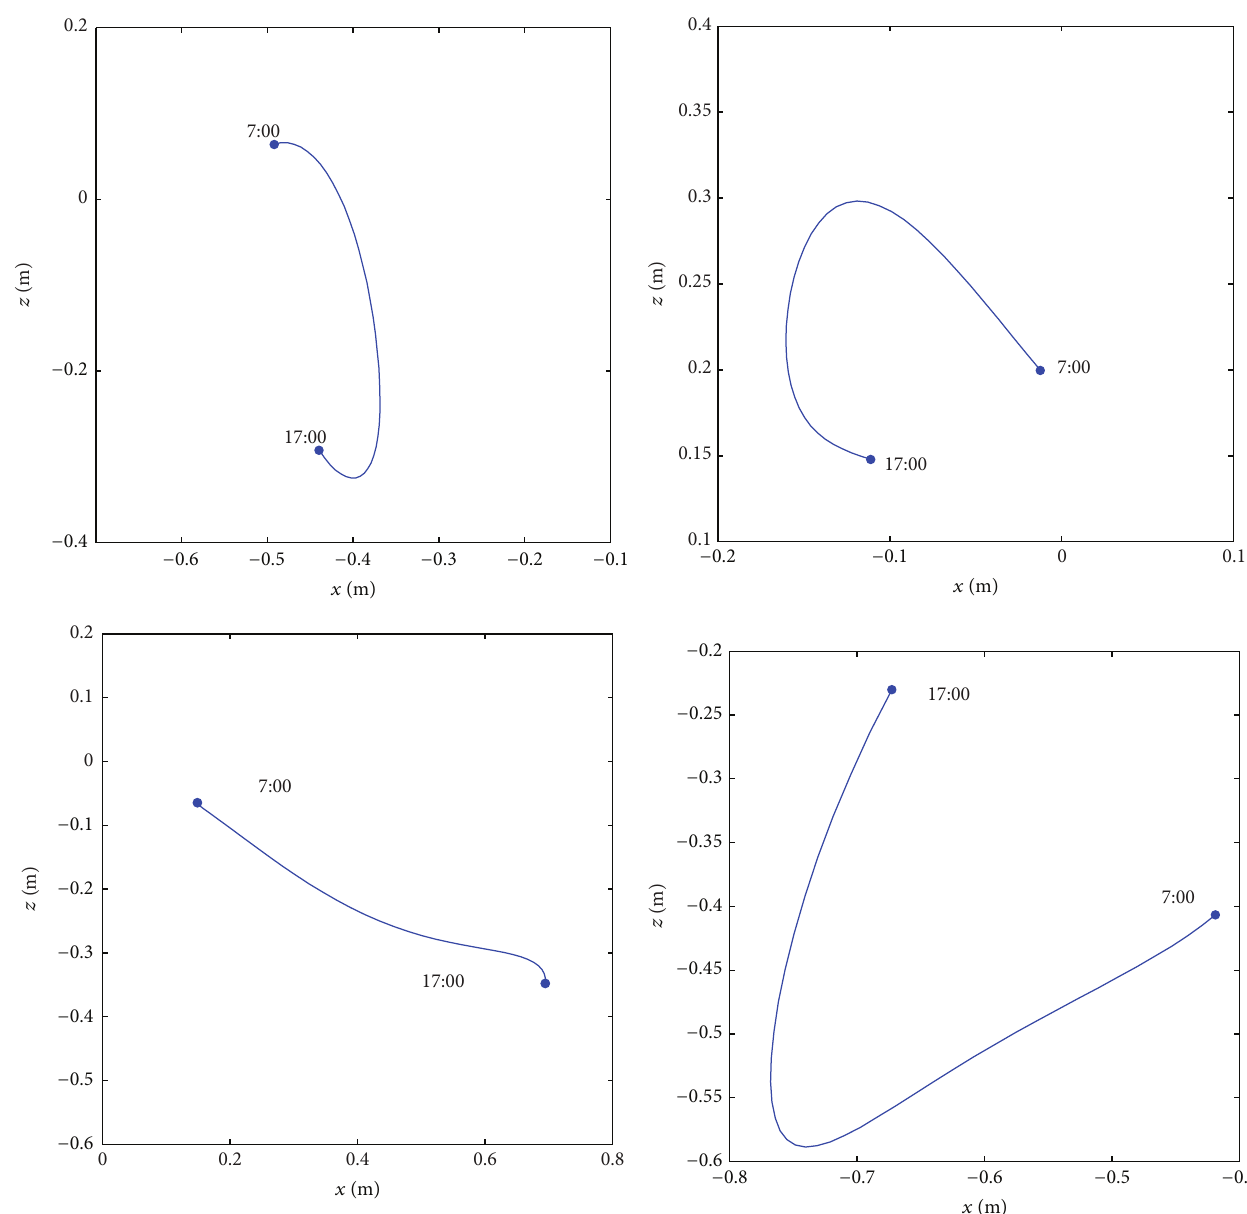
Figure 7: Comparative of image centroid drift curves for individual heliostats. Summer solstice. All errors are between − 3 and